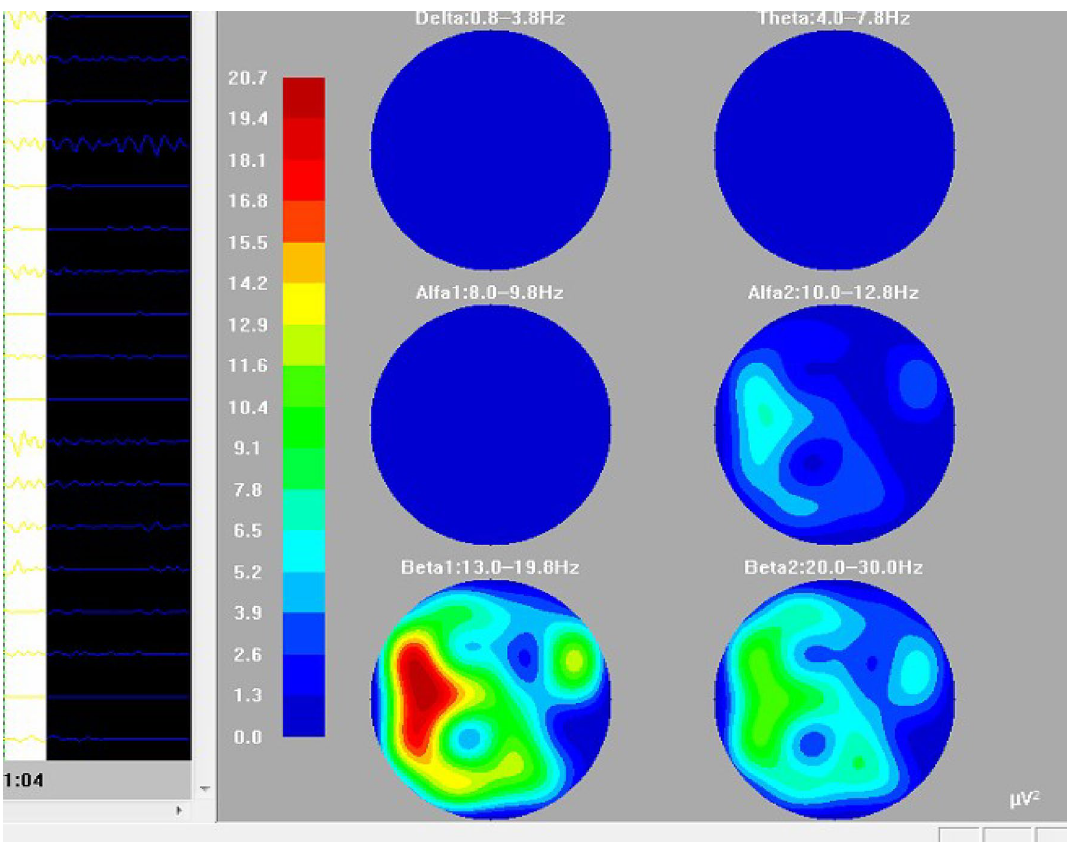
Figure 3. Brain colour spectral mapping of EEG power waves. EEG brain mapping showing signals in all frequency ranges with Delta and Theta being very minimal and Beta signals being the dominant rhythm in a male